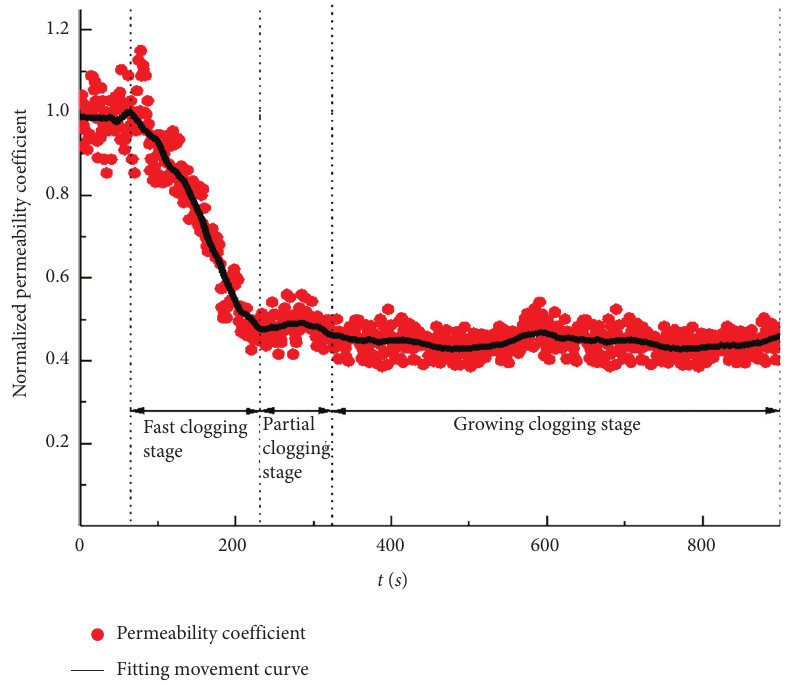
Figure 8: PC specimen clogging process. Analysis of clogging of PC by different horizontal runoff velocities.